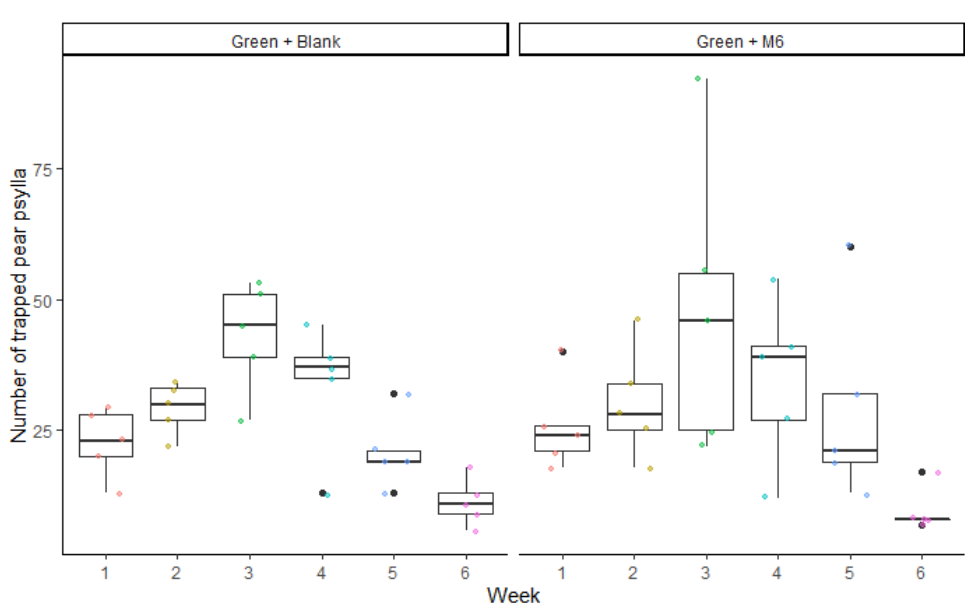
Figure 6. Statistical analysis of Cacopsylla pyri capture rates (time average from Figure 5) per trap- type (green traps equipped with blank nanofibers or green traps equipped with M6-loaded nano- fibers) in field experiment using the Tukey test. The same letters (generalized linear model, Tukey test, p < 0.05) indicate no significant differences. Boxes correspond to the 25th and 75th percentiles, medians appear as lines, and whiskers extend to 1.5 times of the interquartile ranges. Dots repre- sent raw values. Dots with crosses represent the means. 3.3. Release Rates No traces of the solvents acetic acid and formic acid used to produce the fibers were detected in the chromatograms. The compound β -caryophyllene was not detected in the fibers, and eugenyl acetate was only detected during the first two weeks of tests. Since eugenol was consistently detected in all the samples, the statistical analysis of the re-